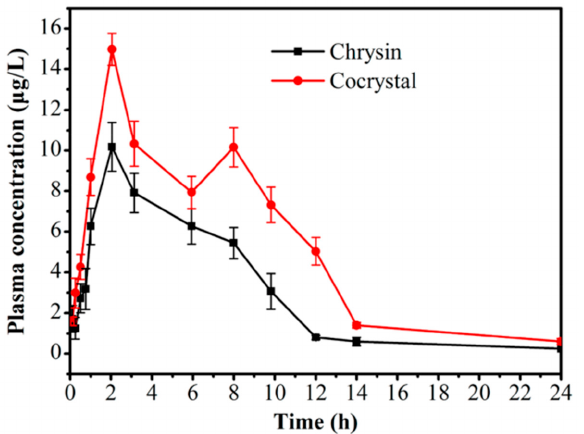
Figure 11. Mean plasma concentrations versus time profiles of chrysin and cocrystal. Adapted from [71] with permission. Copyright © 2018 American Chemical Society.